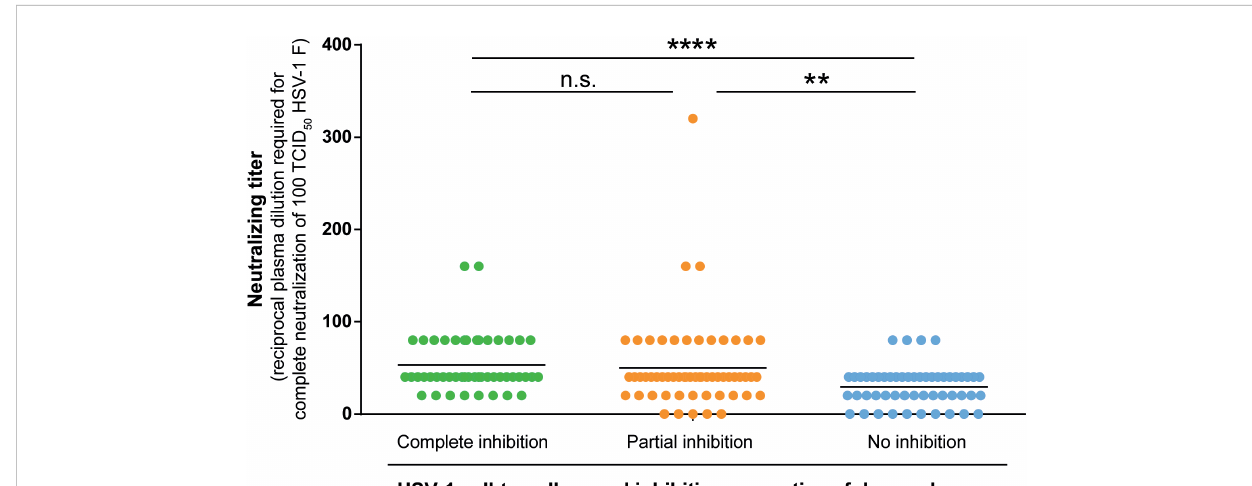
FIGURE 6 HSV-1 neutralizing antibody titers. Neutralizing antibody titers of 158 plasma samples (complete inhibition group n = 47, partial inhibition group n = 58, and the no inhibition group n = 53) were determined with a cell culture-based neutralization assay. Serial dilutions of the respective plasma samples (1:20 to 1:2560) were pre-incubated with 100 TCID50 HSV-1 F for one hour and subsequently added to con fl uent Vero cells in 96-well microtiter plates. After 48 h of incubation, the cytopathic effect was analyzed and the respective neutralization titers were determined. Data sets were statistically analyzed using the One-way ANOVA followed by the Dunn ’ s multiple comparison post-hoc test. Signi fi cant changes (**p < 0.01, ****p < 0.0001) are indicated by asterisks and non-signi fi cant changes (p > 0.05) are labeled as “ n.s. ”